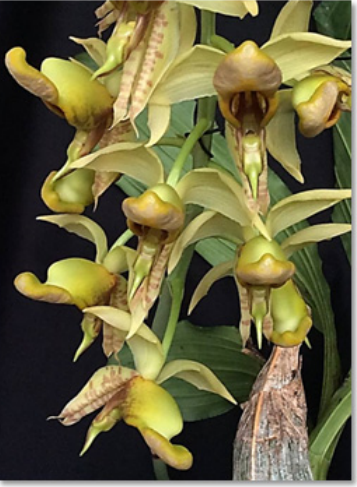
Figure 9. Catasetum galeritum (Source Luiz Otavio Adão) Synonimy: Catasetum galeritum var. pachyglossum Rchb.f. [17]. Geographic distribution: Endemic in Brazil, occurs in riparian or gallery forests, Up- land and floodplain forests, and broadleaf forests in the states of Amazonas, Pará, Tocan- tins, Maranhão, and Mato Grosso [17]. This C. galeritum specimen was sampled initially in the municipality of São Félix do Xingu, Pará state, Brazil, and the constituents of their volatile concentrate are listed in Table 5. Table 5. Constituents identified in the volatile concentrate of C. galeritum flowers. Constituents